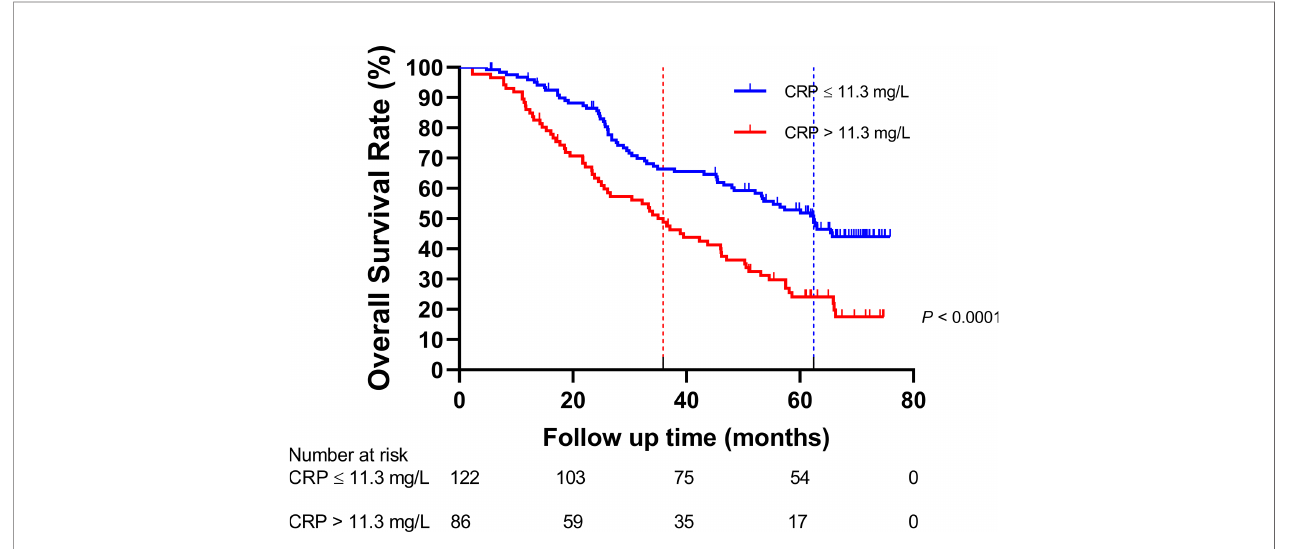
FIGURE 3 | Comparison of the overall survival rate between the group with C-reactive protein (CRP) ≤ 11.3 mg/L and the group with CRP > 11.3